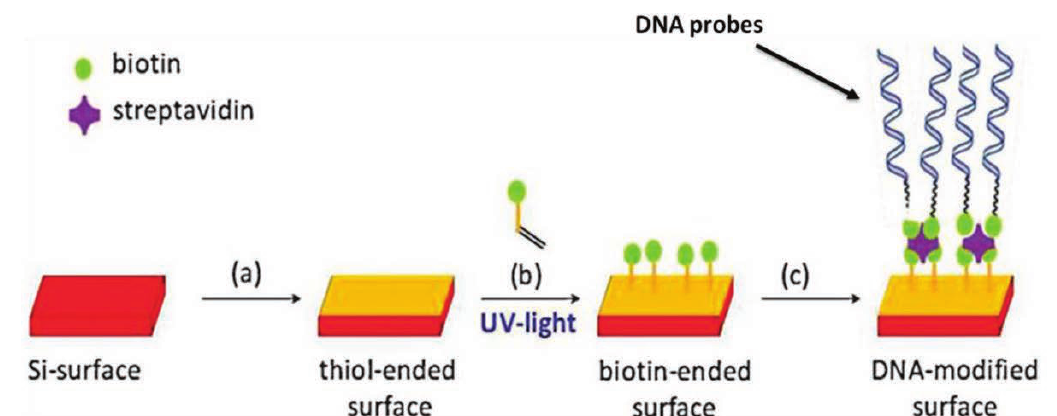
Figure 3. Functionalization of Si/SiO surface through thiol-ene chemistry. Reprinted with permission from [37]. Copyright 2012 Royal Society of 2 Chemistry [37].